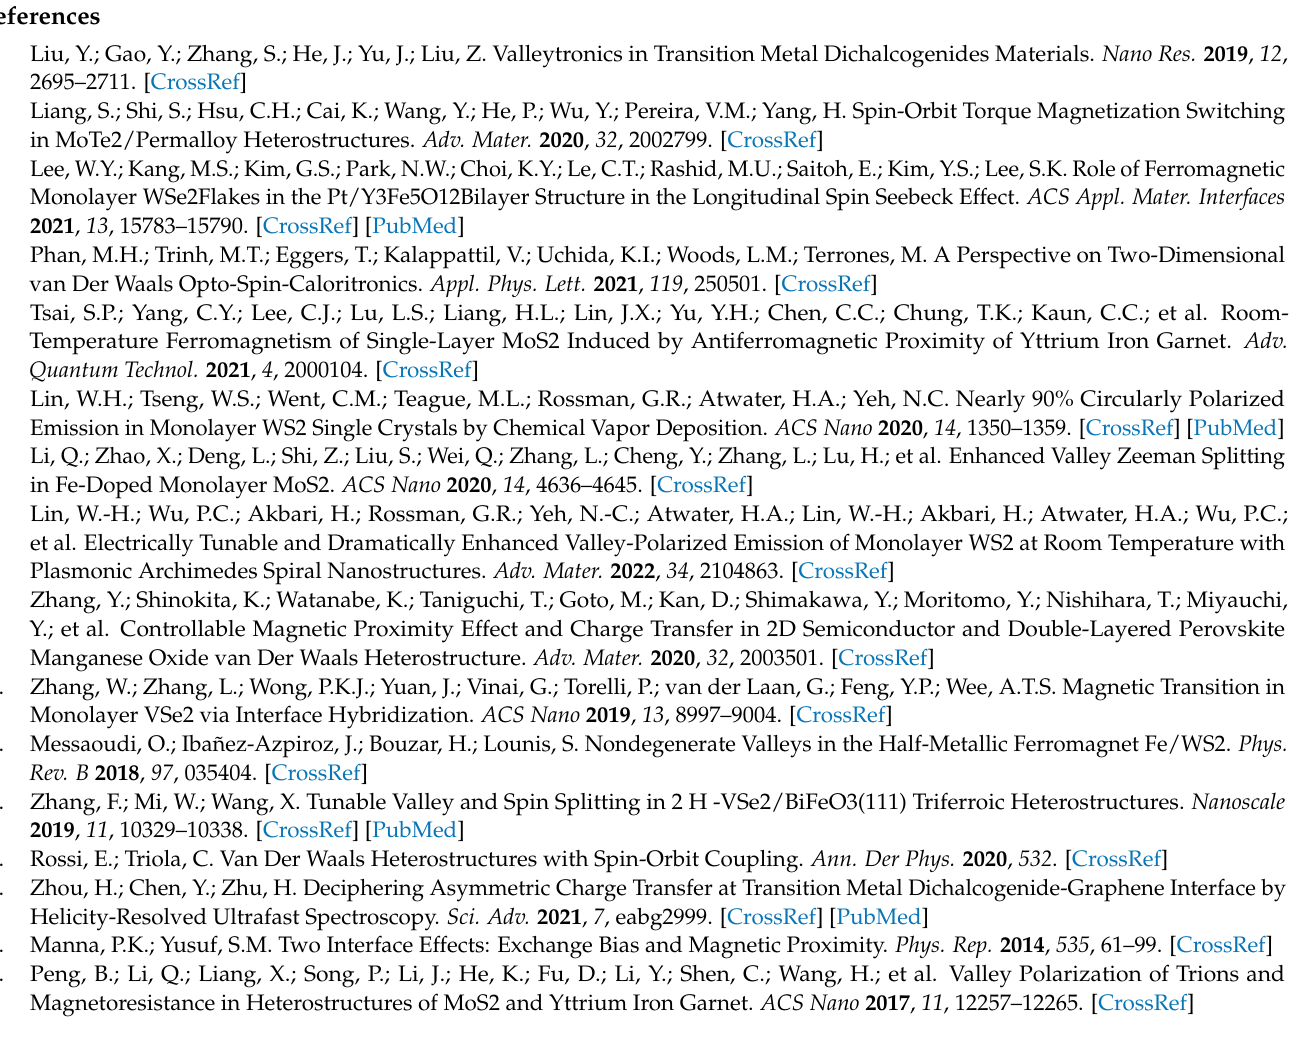
transfer process; Figure S2: Low temperature resistivity behaviors for Pt/BPIO and Pt/WS 2 /BPIO. Figure S3: Temperature-dependent resistance measurement of pure